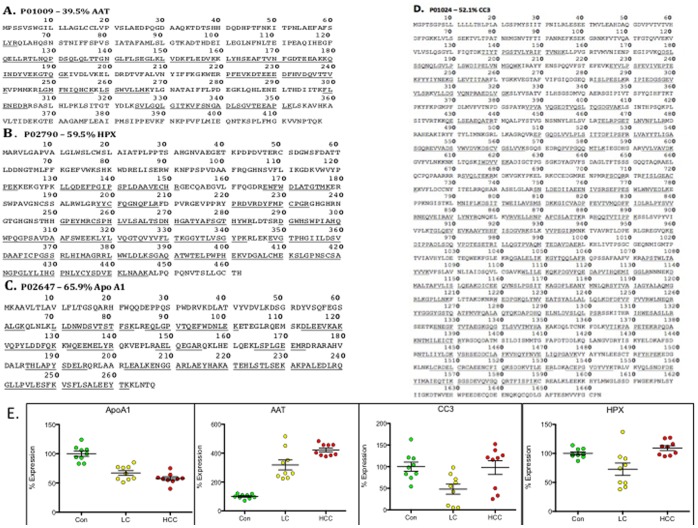
Identification of differentially expressed proteins in plasma from control, cirrhosis and HCC subjects by label-free quantitative MS.(A–D) Sequence coverage levels for differentially expressed proteins identified and selected for independent validation. Underlined sequences represent tryptic peptide fragments identified by MSE. (E) Relative expression plots of robustly identified peptides uniquely attributed to either ApoA1, α1AT, CC3 or HPX and comparing their relative mass peak intensities across the three different disease groups.